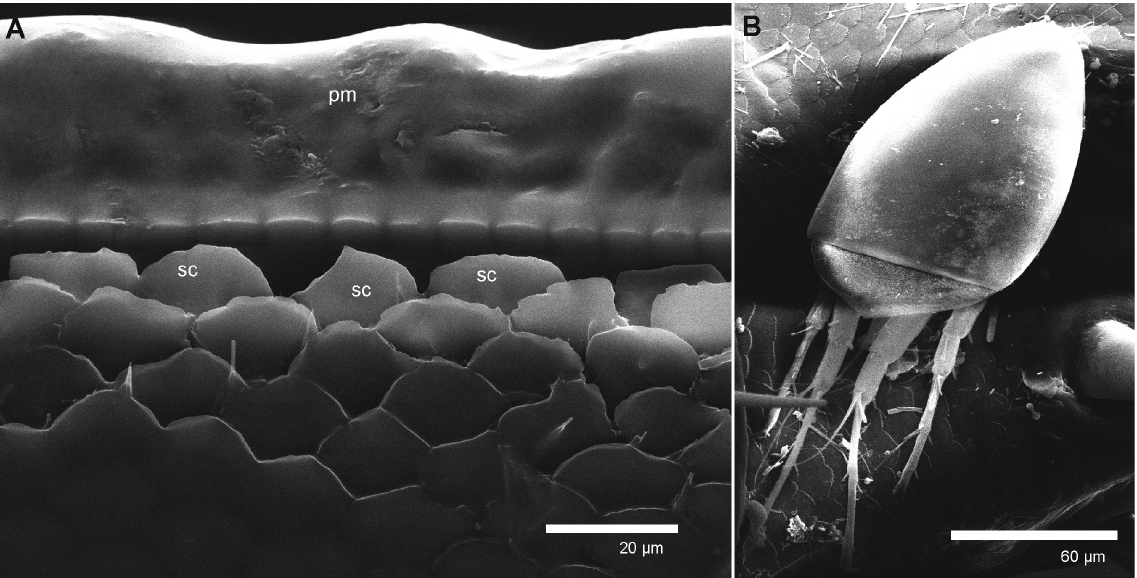
Fig. 3. Dichromatobolus elephantulus gen. et sp. nov., ♂ (ZFMK MYR9896), SEM. A . Limbus of midbody ring. B . Phoretic(?) mite at body ring. Abbreviations: pm = tergite margin; sc = cuticular